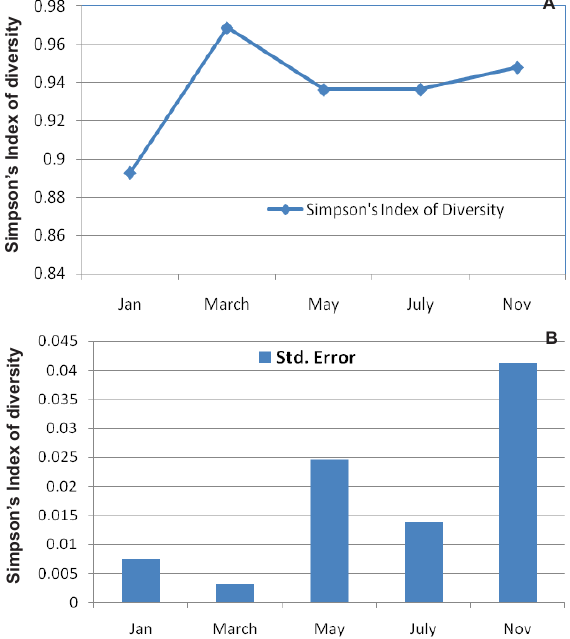
Figure 2. Seasonal variation in (A) species diversity of butterflies, and (B) its standard error in subtropical lowland forests of Bhutan (January 2009–March 2010).